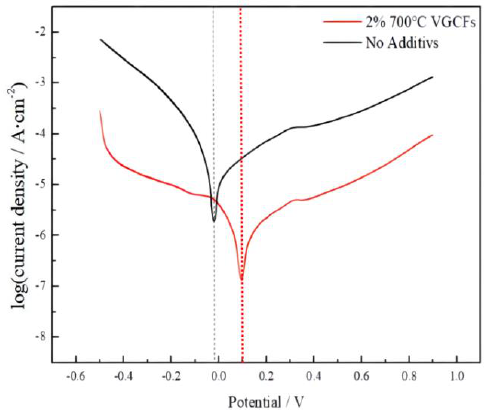
Figure 7. Tafel curves of PEEK/EG and PEEK/EG/VGCFs Composite